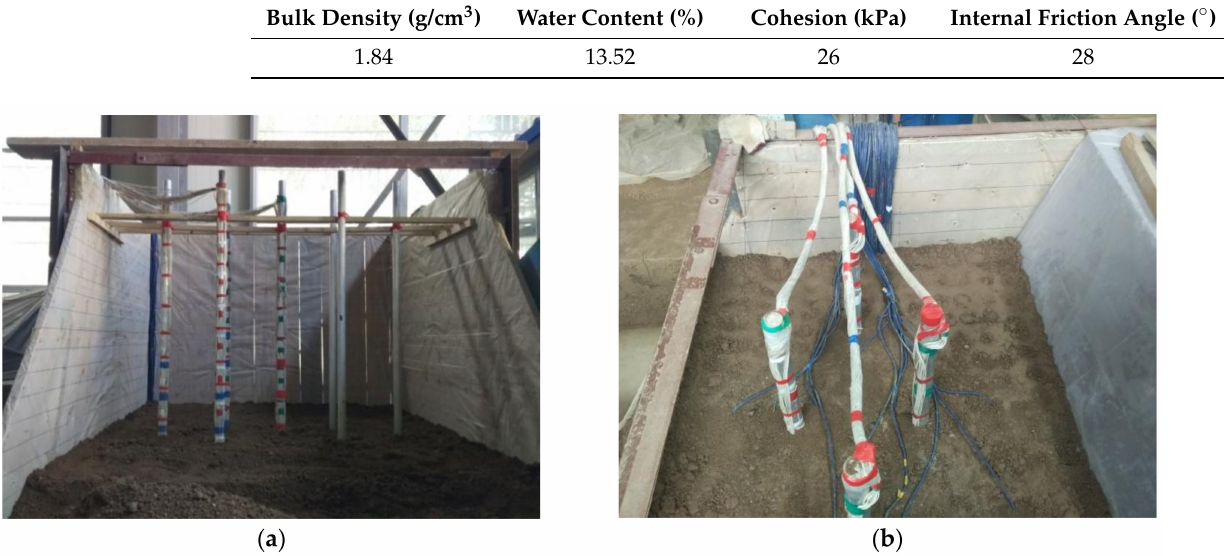
Figure 2. Filling of soil: ( a ) layered filling of sliding bed; ( b ) layered filling of sliding